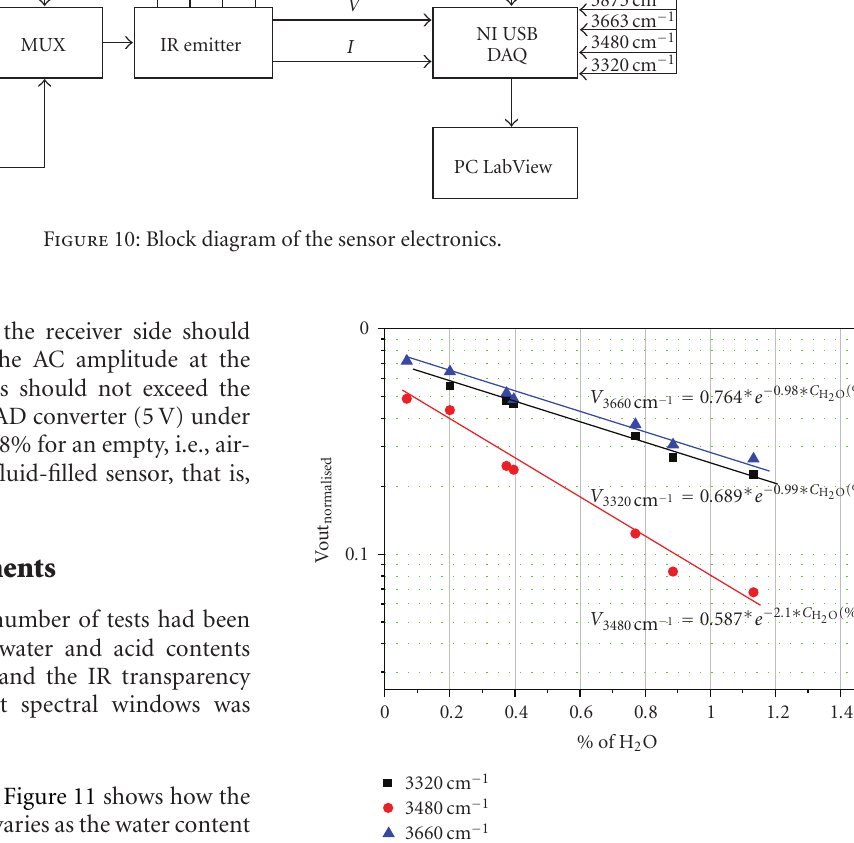
Figure 11: Variation of the thermopile detector output with the water content of Skydrol LD-4. The curve with the steep slope refers to the 3480 cm − 1 centre absorption band and the shallower ones to the high- and low-energy absorption bands around 3660 cm − 1 and 3320 cm − 1 , respectively. The output signals were normalized to the 3875 cm − 1 reference